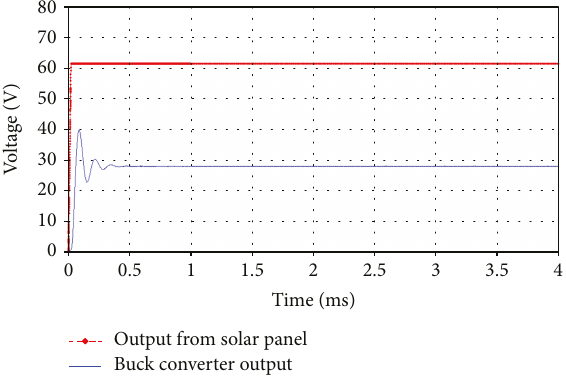
Figure 8: Input and output voltage waveforms of the MPPT buck converter for 80V input.